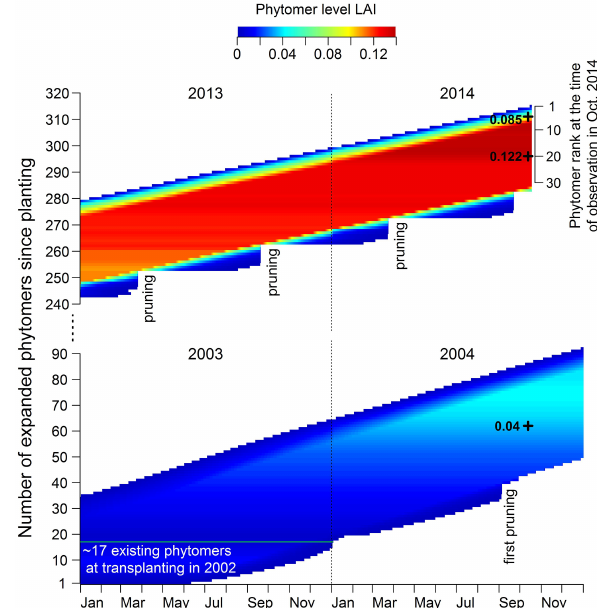
Figure 5. Simulated phytomer-level LAI dynamics (horizontal color bar) compared with field observations (black crosses with measured LAI values). A phytomer in the model is only meant to represent the average condition of an age cohort of actual oil palm phytomers across the whole plantation landscape. The newly ex- panded phytomer at a given point of time has a rank of 1. Each horizontal bar represents the life cycle of a phytomer after leaf ex- pansion. Phytomers emerge in sequence, and the y axis gives the total number of phytomers that have expanded since transplanting in the field. Senescent phytomers are